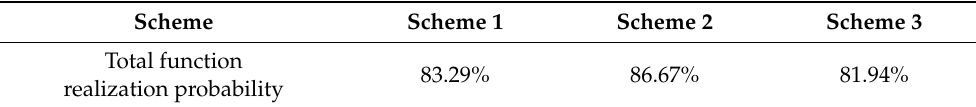
Table A1. Comparison of Function Realization Probability of Three Physical Prototypes.